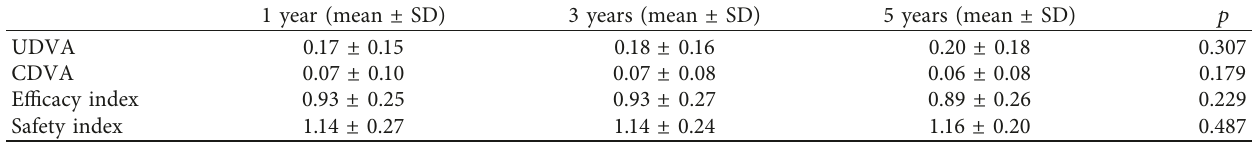
Table 2: Visual acuities, efficacy index, and safety index during postoperative follow-up.